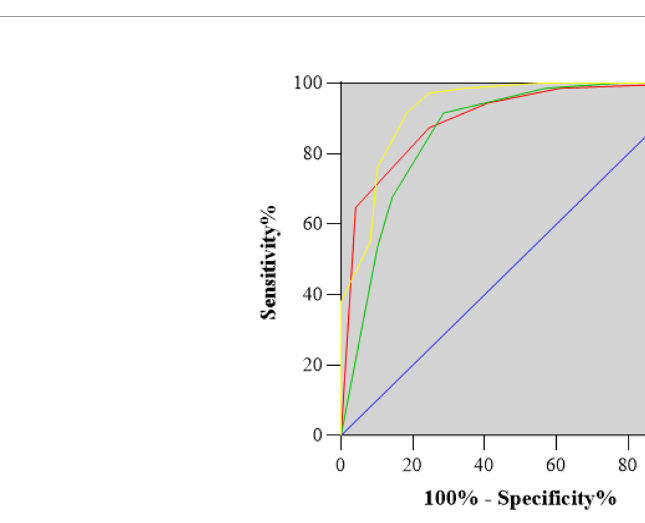
FIGURE 2 | Receiver operating characteristic (ROC) curve for US and MRI classi fi cation of the total scores. The area under the curve (AUC) was 0.86 and 0.89, respectively. ROC curve for the combination of US and MRI classi fi cation of the total scores. The AUC was